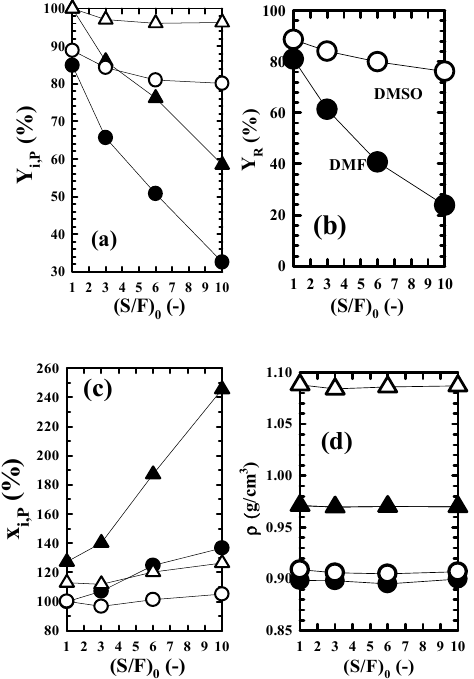
Figure 4. Comparison of solvent for ( a ) Y i,P , ( b ) Y R , ( c ) x i,P , and ( d ) ρ according to mass ratio of solvent to raw material in initial state (S/F) 0 . Experimental conditions: t = 72 h, y w,0 = 0.03, T 0 = 28 °C. Keys are shown in Figure 2.